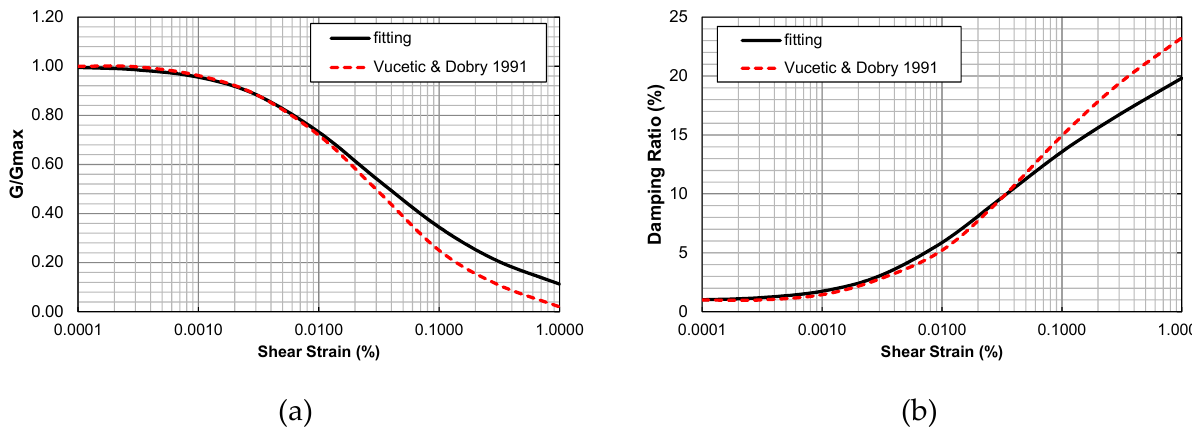
Figure 2. ( a ) Relationship between G/G max and shear strain, ( b ) relationship between material damping ratio and shear strain.